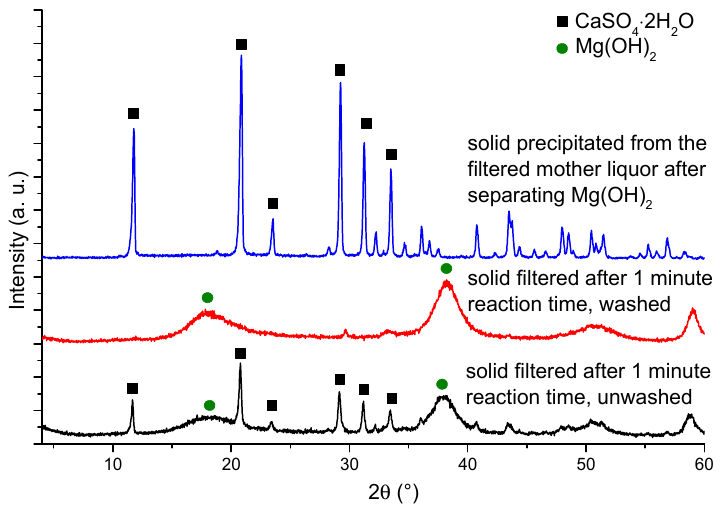
Figure 7. XRD patterns of the separated, precipitated solids; main reflections were identified using the JCPDS database (CaSO 4 ·2H 2 O: #21-0816 and Mg(OH) 2 : #84-2164) Washing of Mg(OH) 2 with distilled water, four times the volume of taken sample.